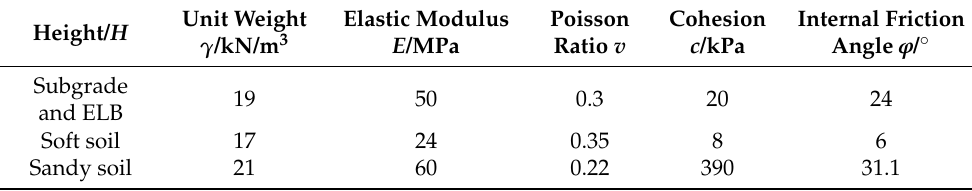
Table 1. Physical and mechanical parameters of the model.